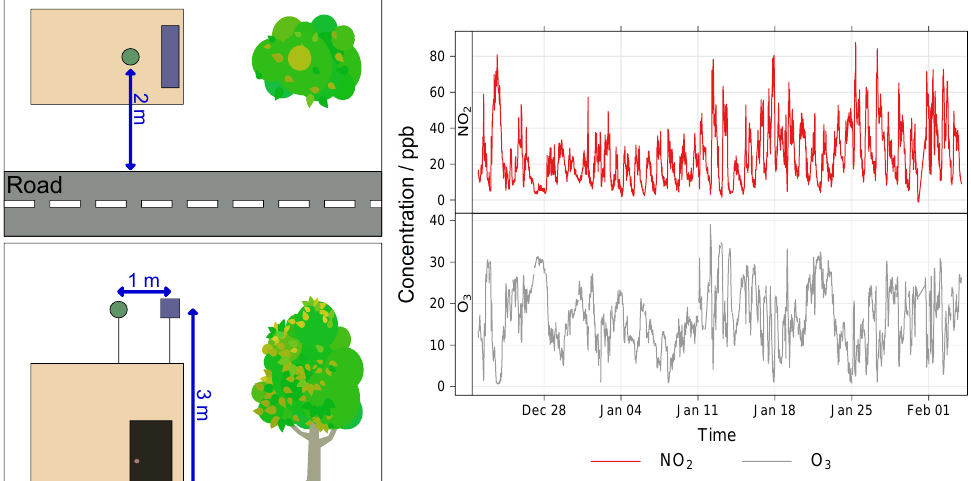
Figure 8. MOx Field calibration and validation setup ( left ) and pollutant time-series ( right ). In the setup schematic the node location is the blue rectangle and the reference inlet is the green